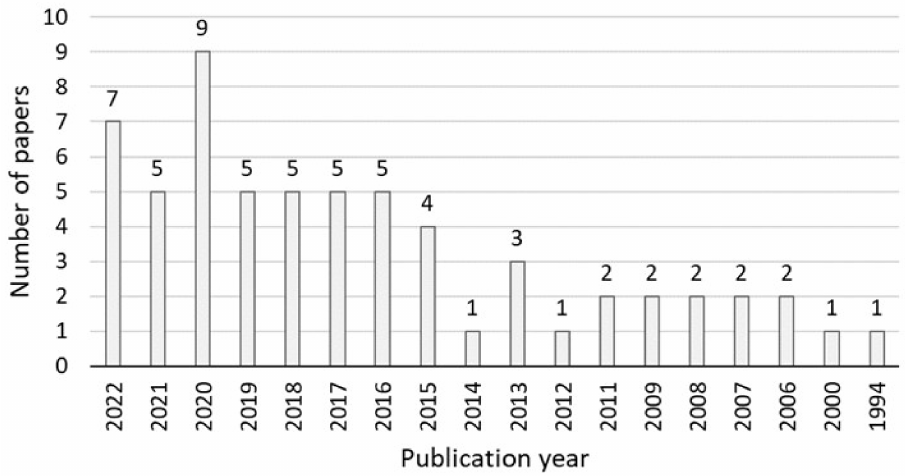
Figure A2. Papers found for each publication